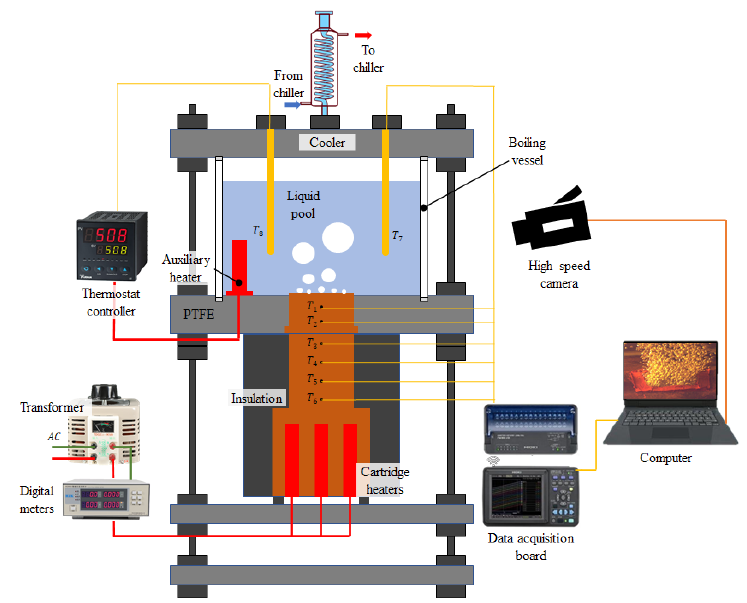
Figure 5. Experimental apparatus for pool boiling.